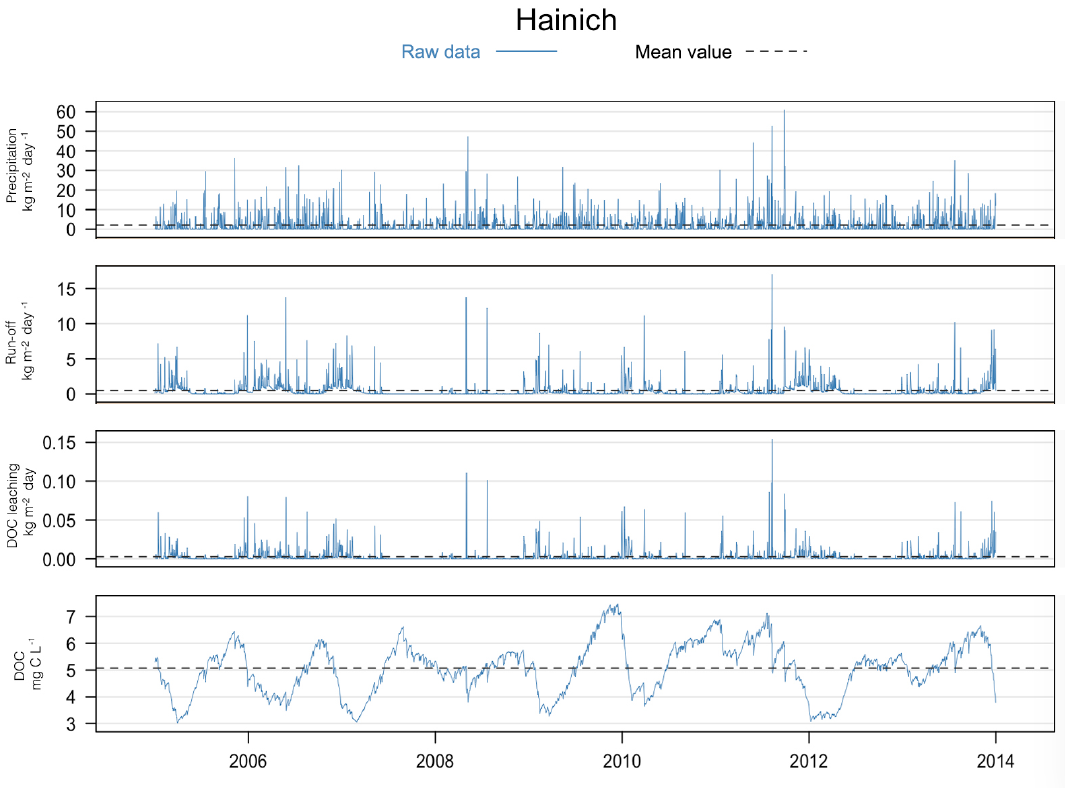
Figure 6. Observed precipitation, simulated run-off, DOC leaching, and DOC concentration in Hainich from 2006 to 2013 indicating the relation between the averaged DOC concentrations in 3m of soil with leaching as a result of run-off that follows large precipitation